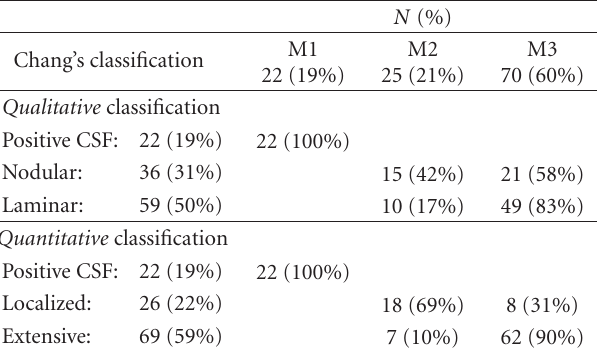
Table 1: Qualitative and quantitative classifications according to Chang’s.